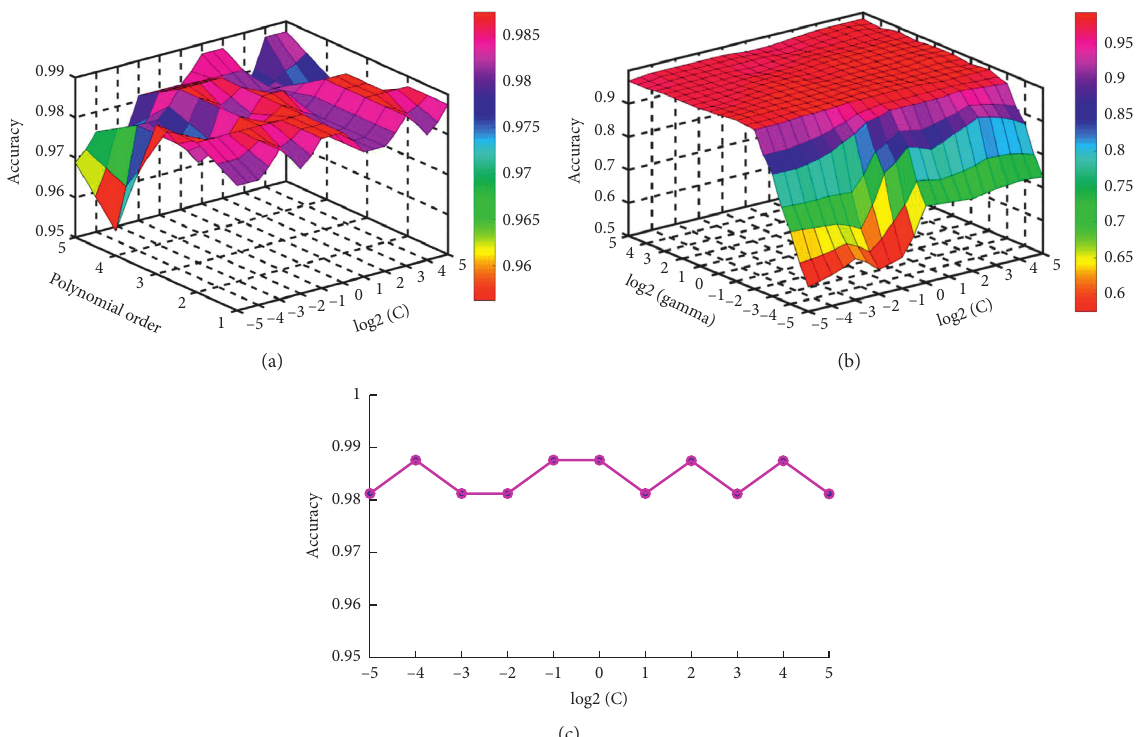
Figure 7: (a, b) The 3D map of classification accuracy as a function of parameter C and polynomial order d , parameter C and gamma c , respectively. (c) Dependence of classification accuracy on parameter C for a linear PCA-SVM